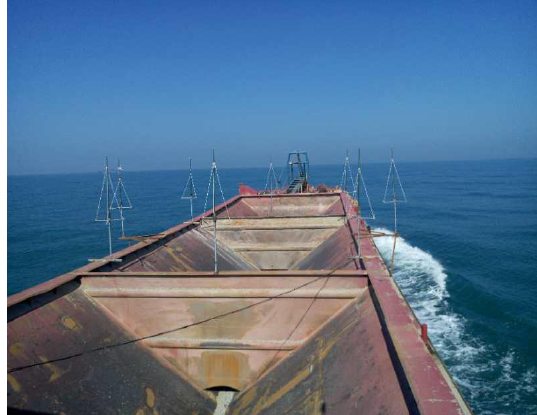
Figure 2. Anchored ship platform and circular phased-array receiver antennas consisting of eight monopole